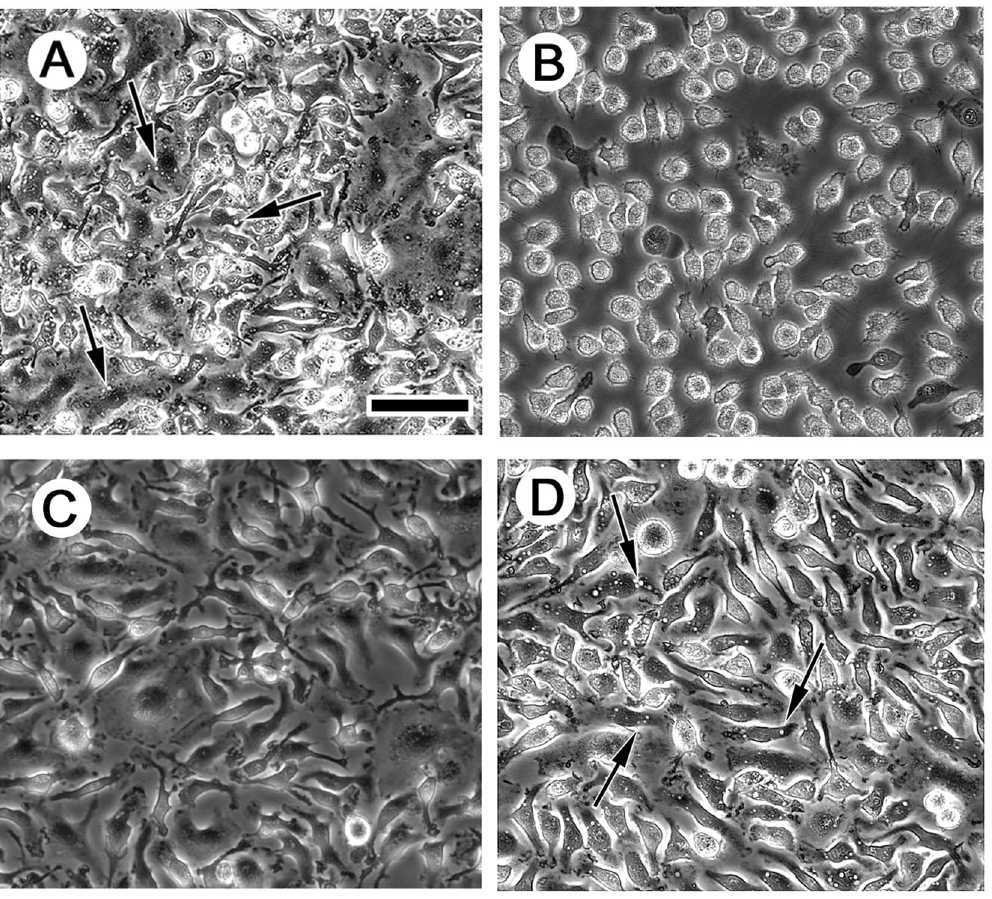
Figure 7. Macrophage macropinosome formation is dependent on dynamin and vacuolar type H( + )-ATPase. Wild-type M-CSF differentiated macrophages were pretreated 30 min with the indicated drugs but without serum and M-CSF. Subsequently, macrophages cultures were treated 30 min with fresh serum-free medium containing M-CSF (50 ng/ml) and either drug vehicle (A), 80 m M dynasore (B), 500 nM bafilomycin A1 (C), or 100 m M NSC23766 (D). Then, macropinosome formation was assessed by phase-contrast microscopy. Scale bar in A=75 m m and applies to all. (Also see Videos S9, S10, S11, S12, S13, S14).